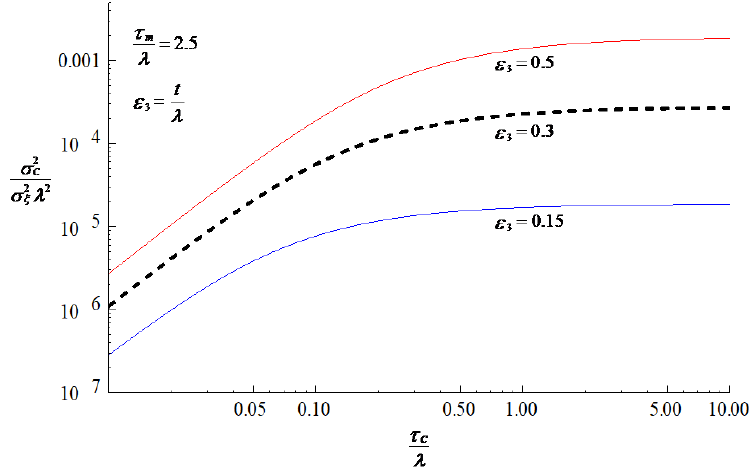
Figure 1. The dependence of dimensionless variance of outflow concentration (Equation (24)) upon the dimensionless inflow response time at various dimensionless time scales.